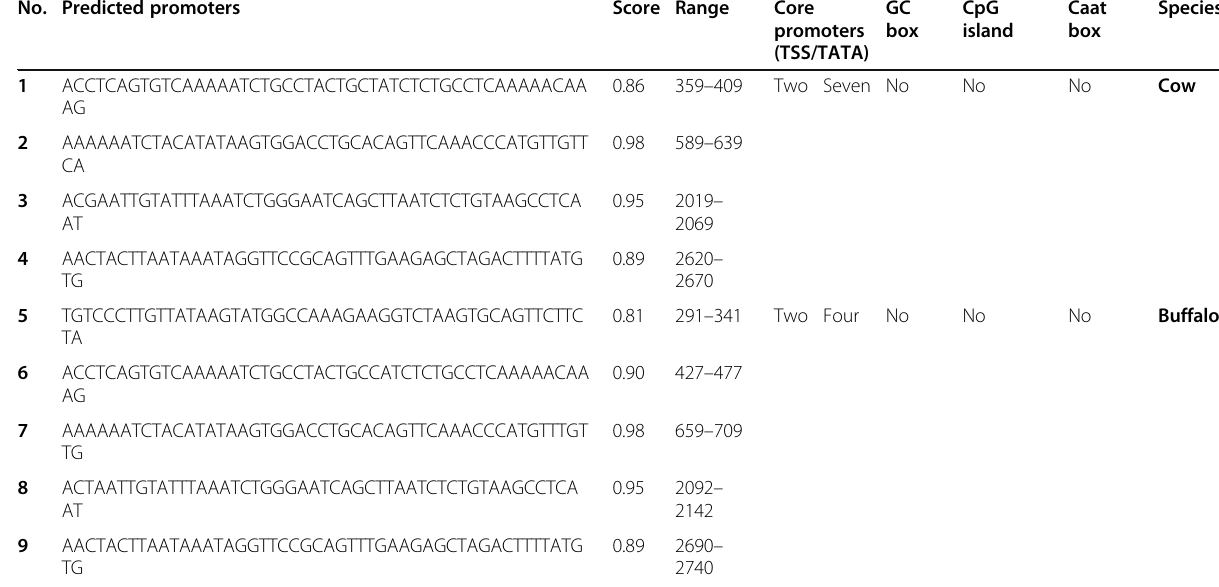
Table 5 List of predicted promoters and other important sequences in upstream of the AKT3 In cow and buffalo No. Predicted